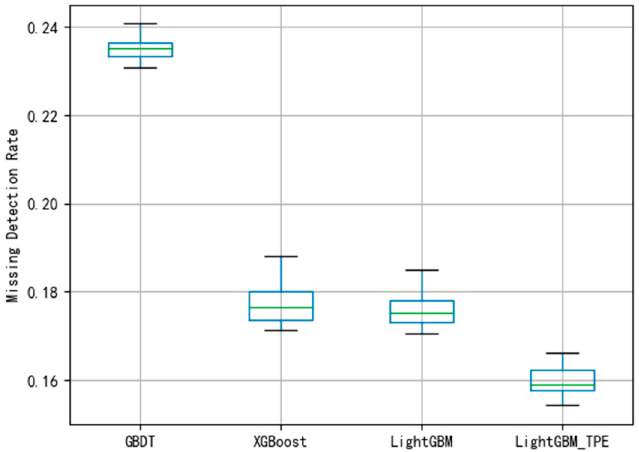
Figure 8. False alarm rates of four algorithms for fault detection of wind turbines gearboxes on dataset 2.